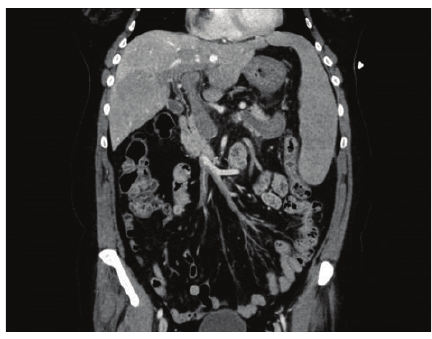
Figure 3: Superior mesenteric thrombosis.